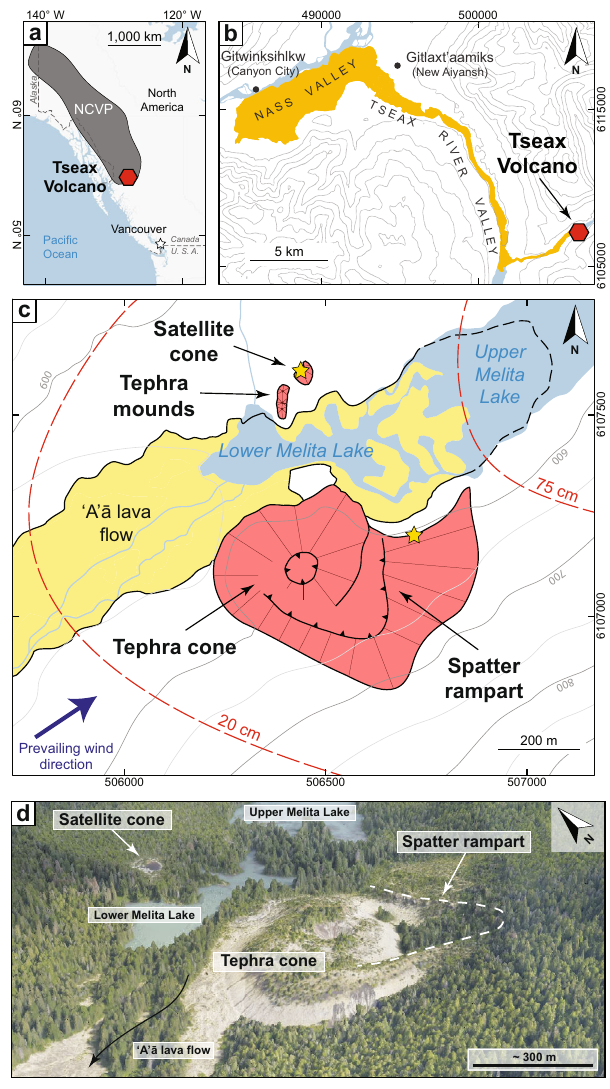
Fig. 1 Location and description of the area surrounding Tseax volcano. a Tseax (red hexagon) in the context of Neogene-Quaternary volcanic centres and complexes of the Northern Cordilleran Volcanic Province (NCVP). b Map of Tseax and the 32-km-long valley- fi lling lava fl ows (yellow). c Volcanological map of Tseax cone, the Satellite cones and spatter rampart, all shaded in red. Yellow stars indicate locations of in fl ated pyroclast samples. Red contours denote tephra deposit thickness. Modi fi ed after Le Moigne et al. 44 . d Oblique 3D view of Tseax and surrounding area generated by digital photogrammetry. Modi fi ed after Le Moigne et al. 44